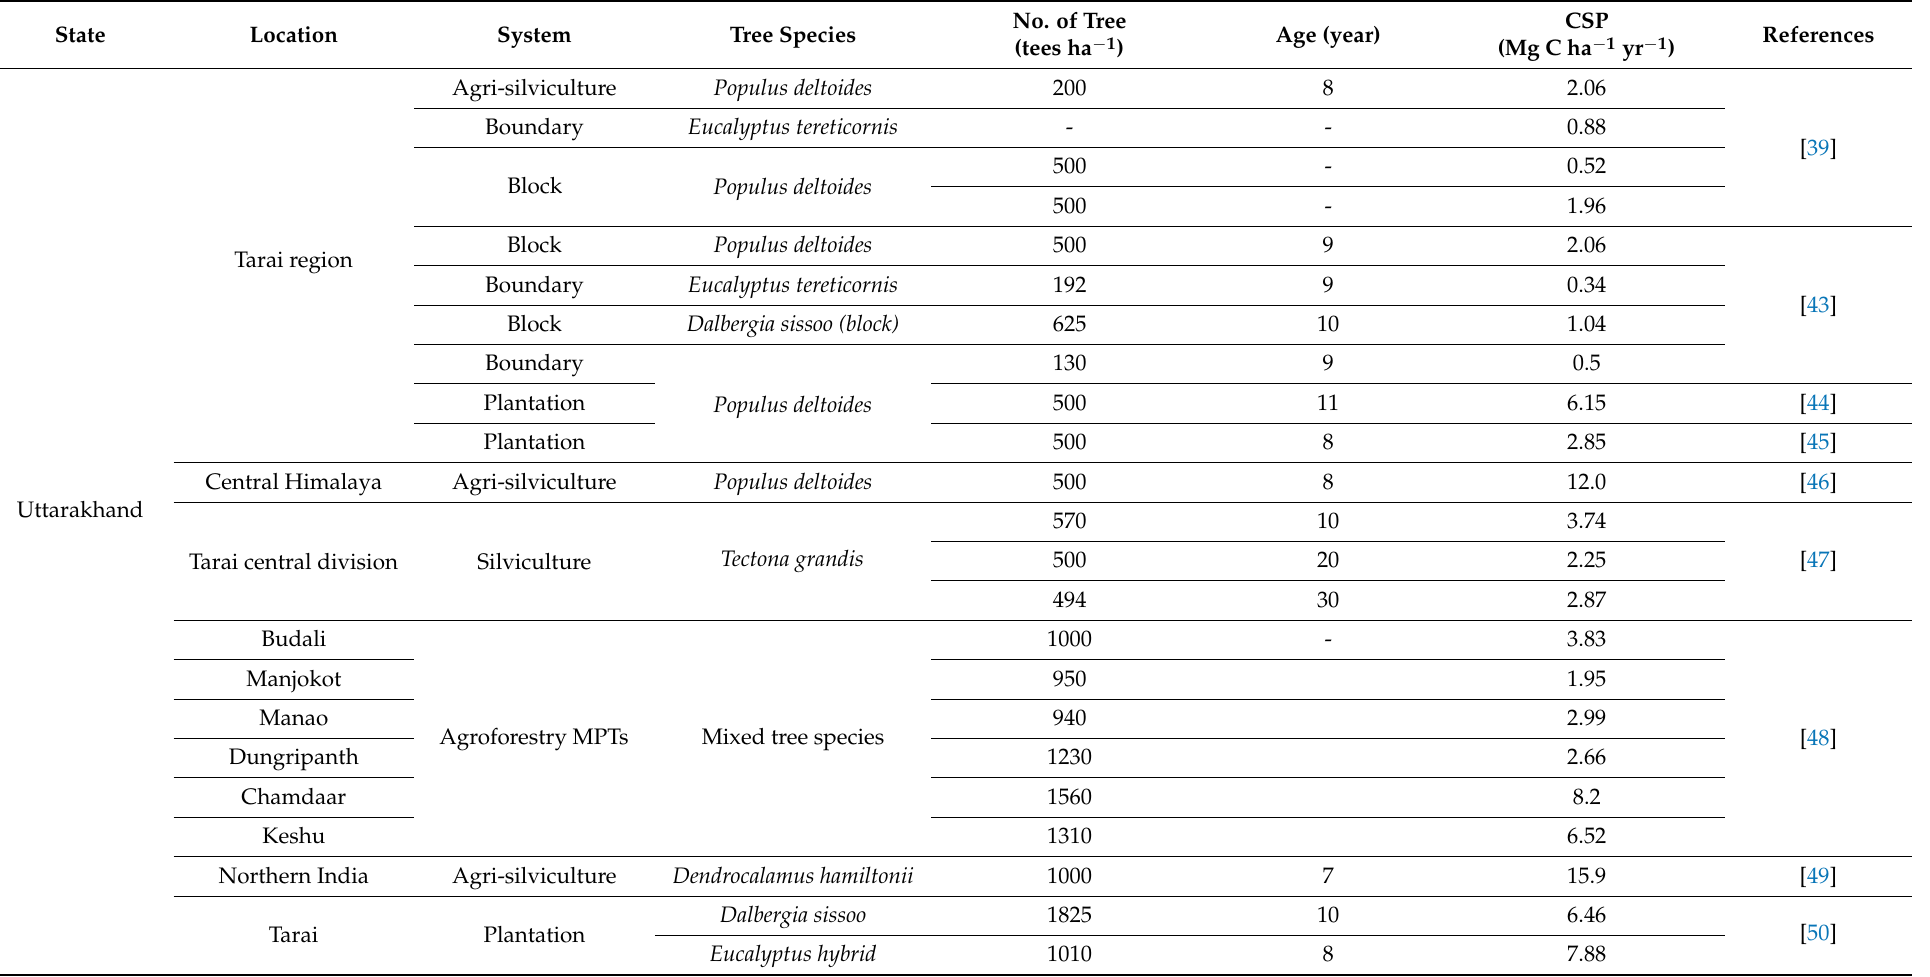
Table 3. Carbon sequestration potential of agroforestry tree species in Indo-Gangetic plains of